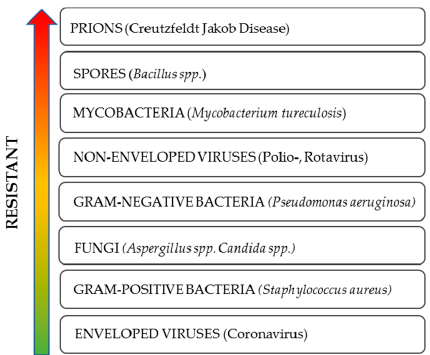
Figure 1. Resistance of microorganisms to sterilization and/or disinfection [16,17].